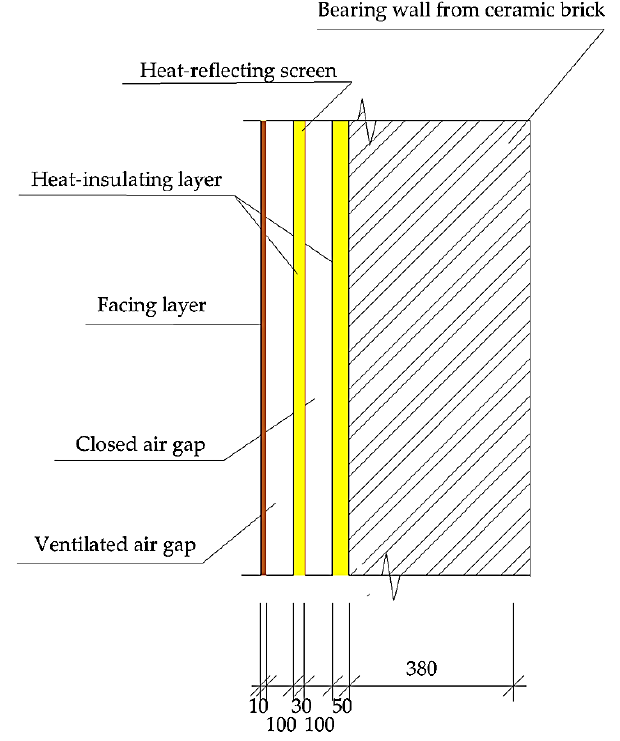
Figure 3. multilayer wall enclosing structure with homogeneous bearing, heat-insulating layers and ventilated air gaps with a heat-reflecting screen-aluminum foil on the outer surface of a closed air gap (the thickness of the layers of the structure is given in millimeters).